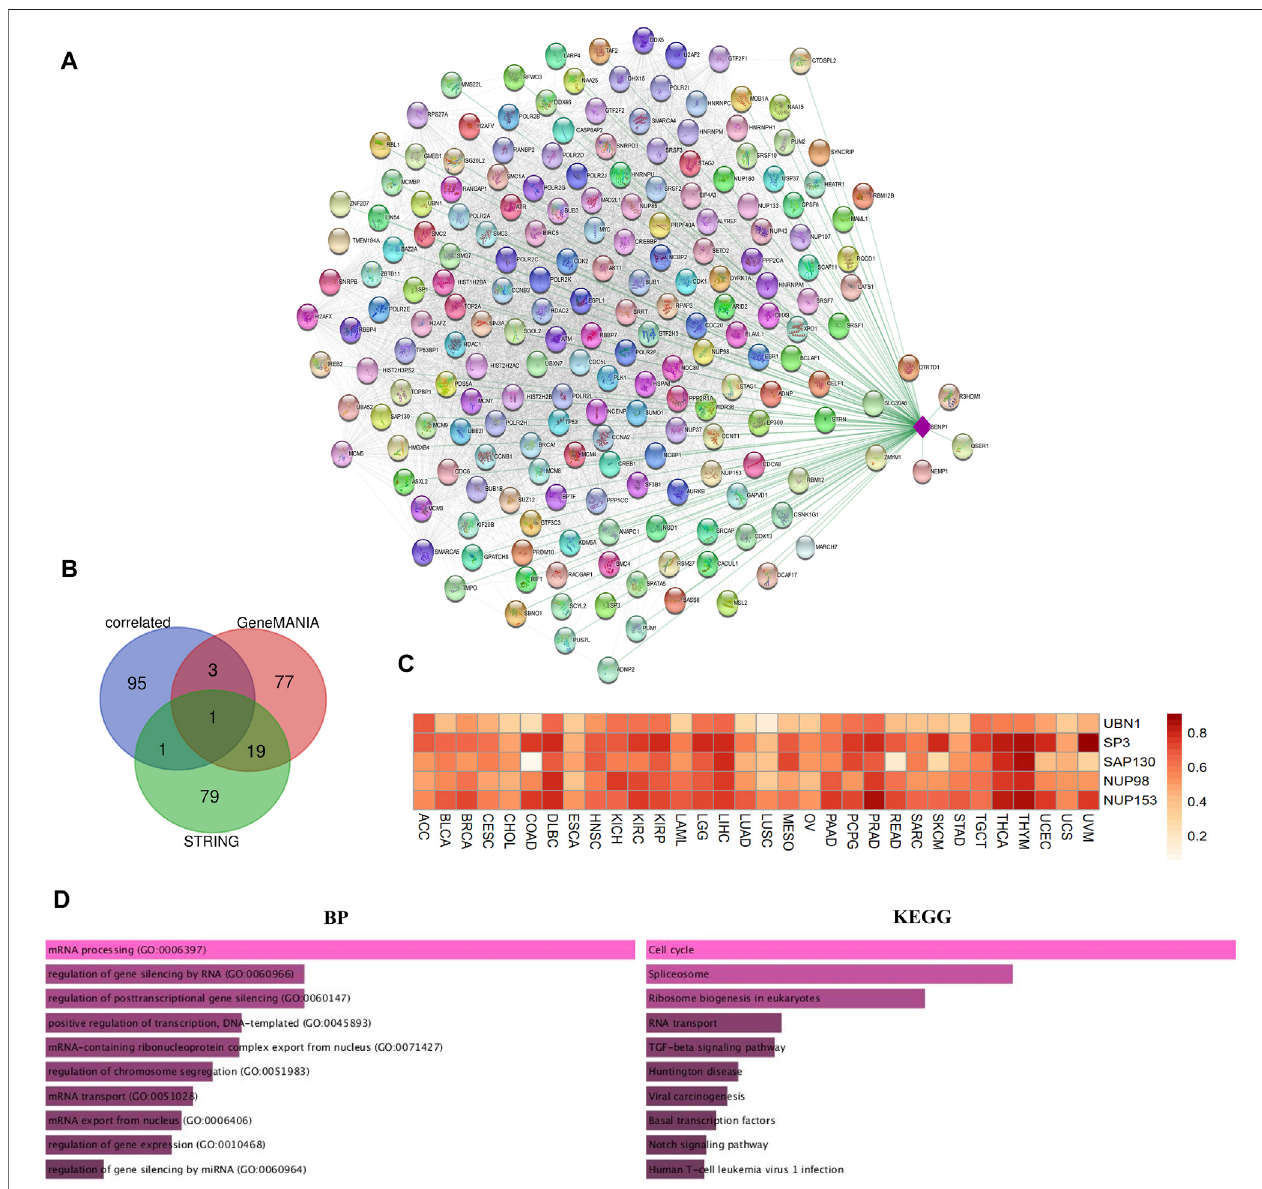
FIGURE7| The roleofSENP1 infamous cancerrelated-pathways(GSCALite),and thedrugresistanceanalysisofcommon genesbasedonGDSCdrugdata. (A) Piechartofpathwayactivity, (B) Heatmapofpathwayactivity,and (C) HeatmapofdrugscorrelatedwithsixgenesNUP153,SP3,SAP130,NUP98,UBN1,andSENP1.